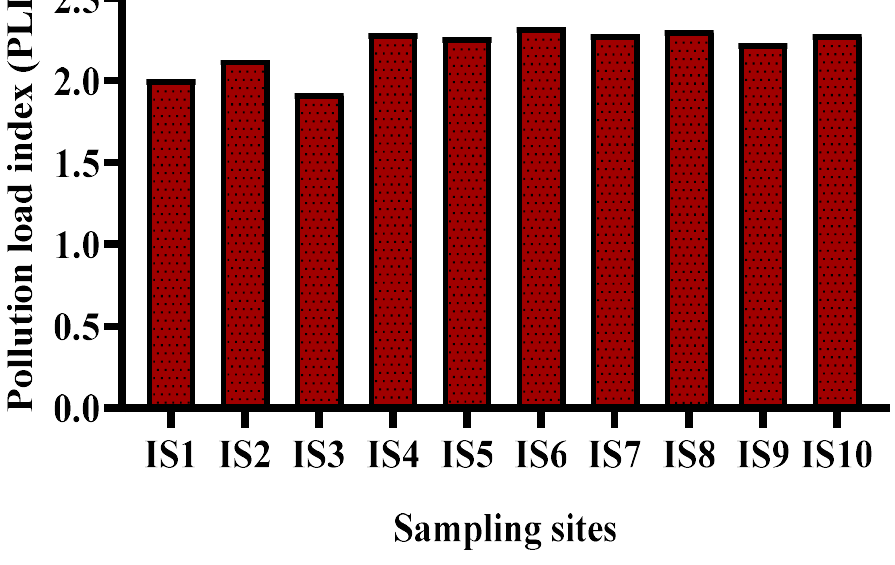
Figure 2. Pollution load index of the sampling sites of the study area.